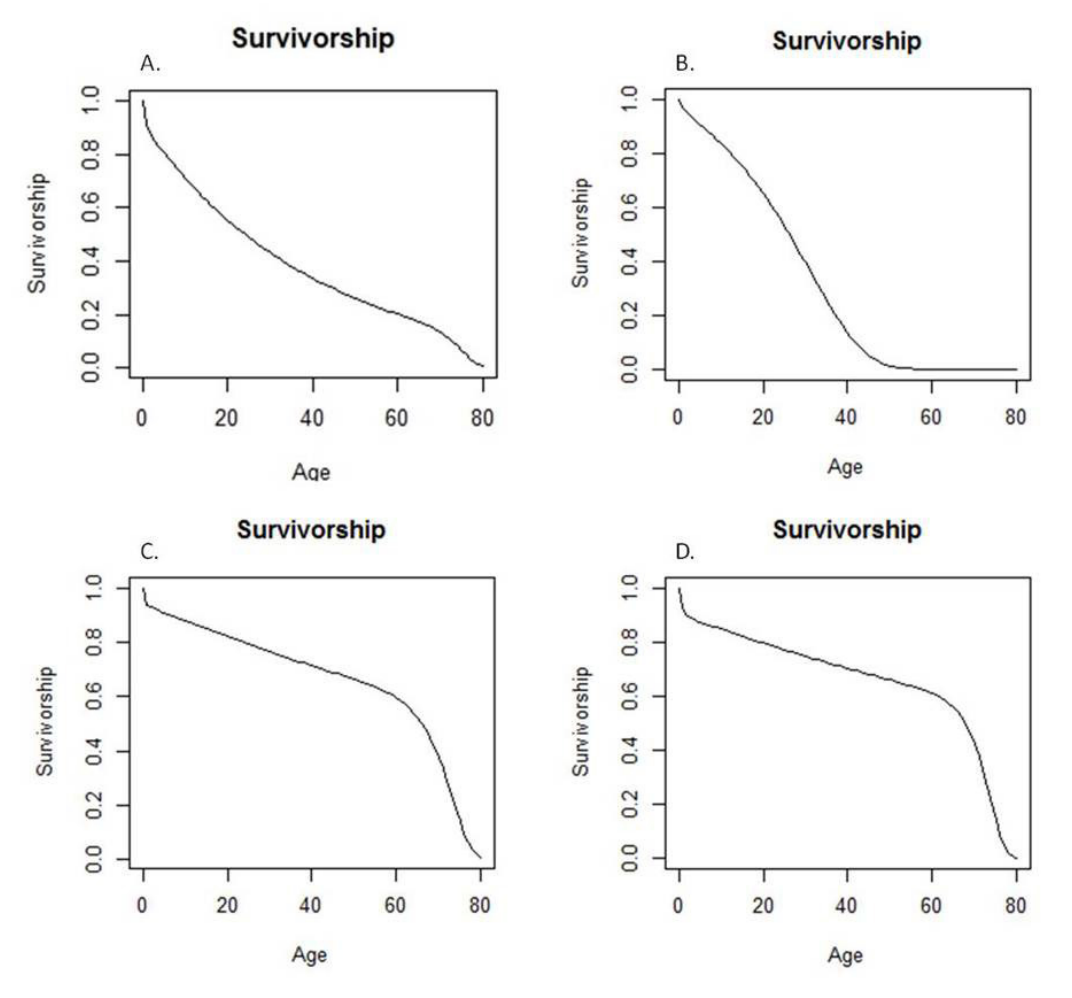
Figure 6. Result of the Siler model for survivorship for Falköping stad 5 (a), Karataș, Turkish Bronze Age 2500–2300 BC (b) (Angel, 1969, available in Weiss & Wobst, 1973), nomadic Saami (c), and settled Saami 1796–1840 (d) (Wahlund,